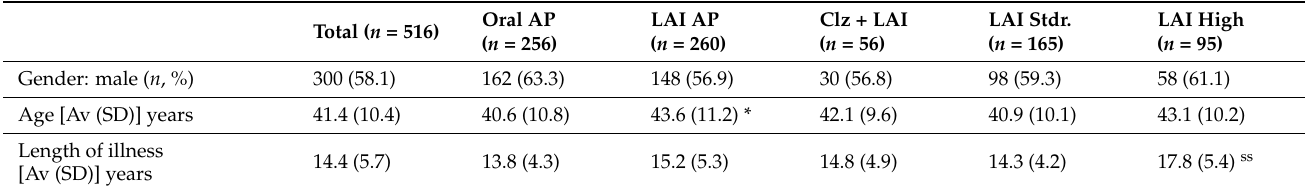
Table 1. Patients’ sociodemographic and clinical characteristics by the antipsychotic